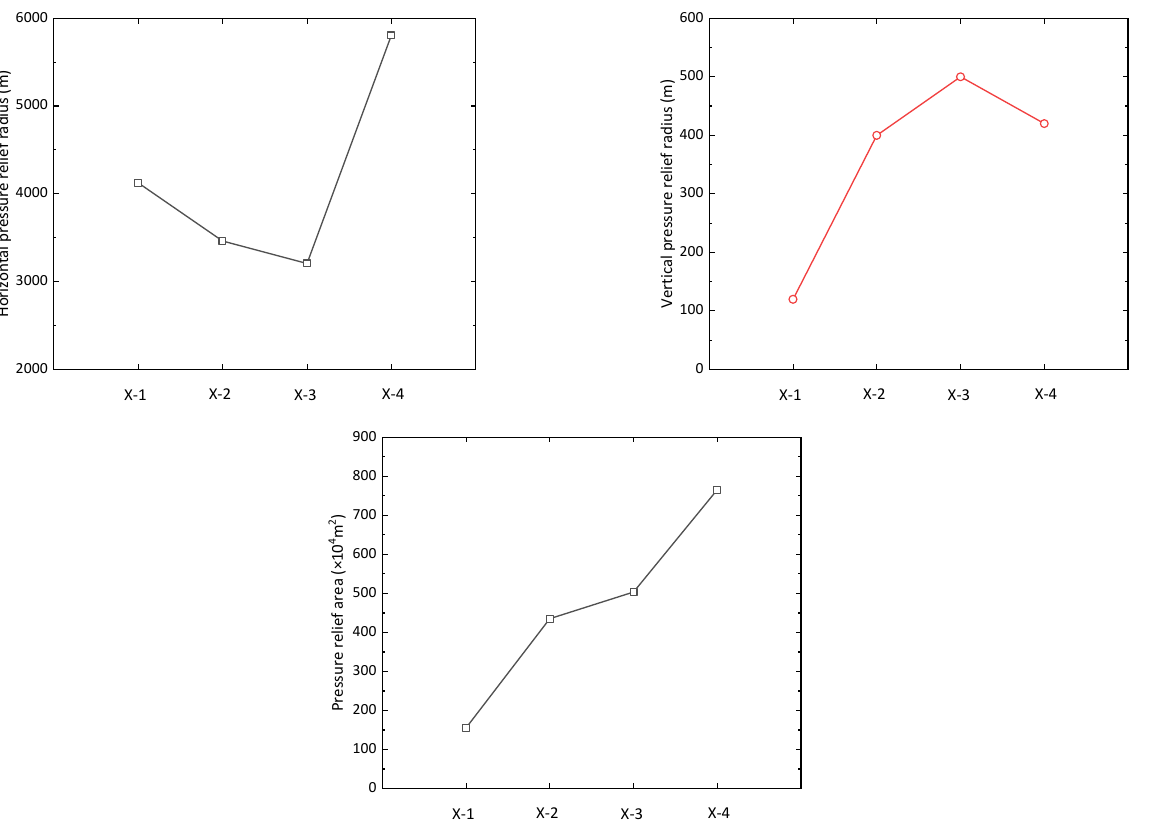
Figure 10. Transverse relief radius, longitudinal relief radius, and relief area around each well on profile A.